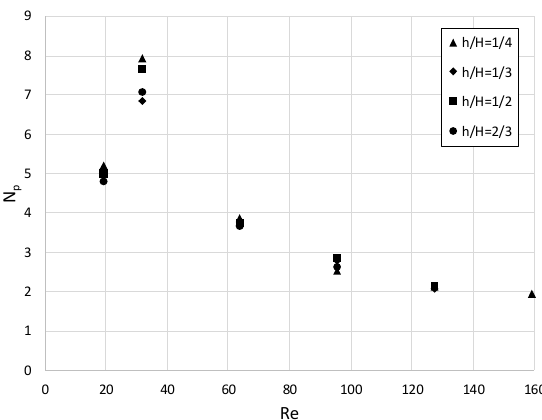
Fig. 4. Power number N p for novel impeller and for different impeller distances from tank bottom.